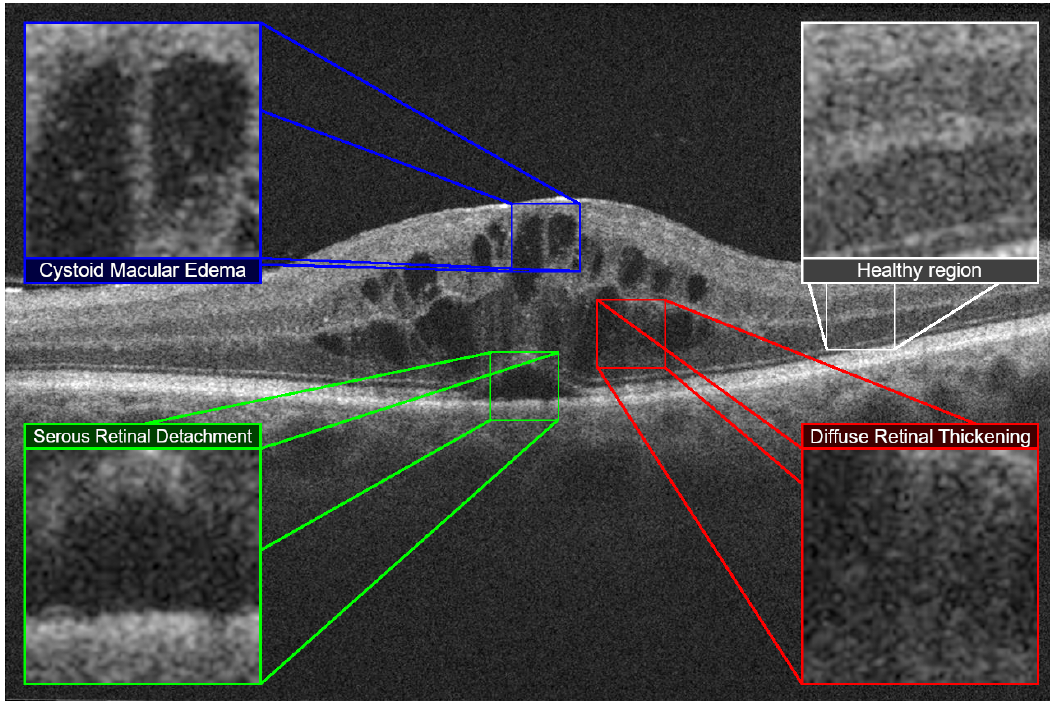
Figure 1. OCT image with the 3 different clinically defined types of DME as well as an example of healthy